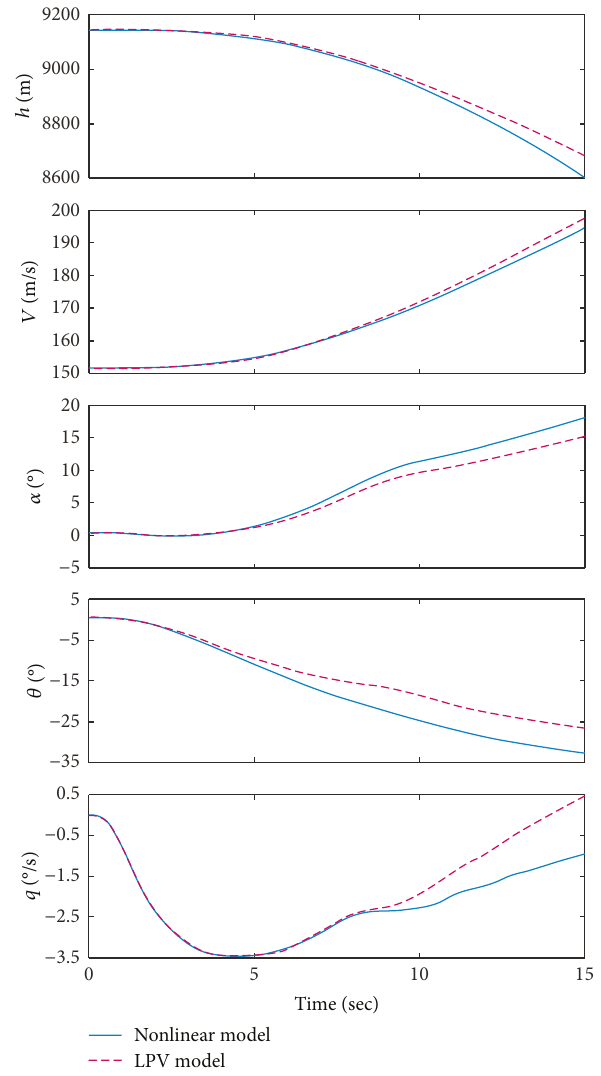
Figure 8: Nonlinear model versus the LPV model.